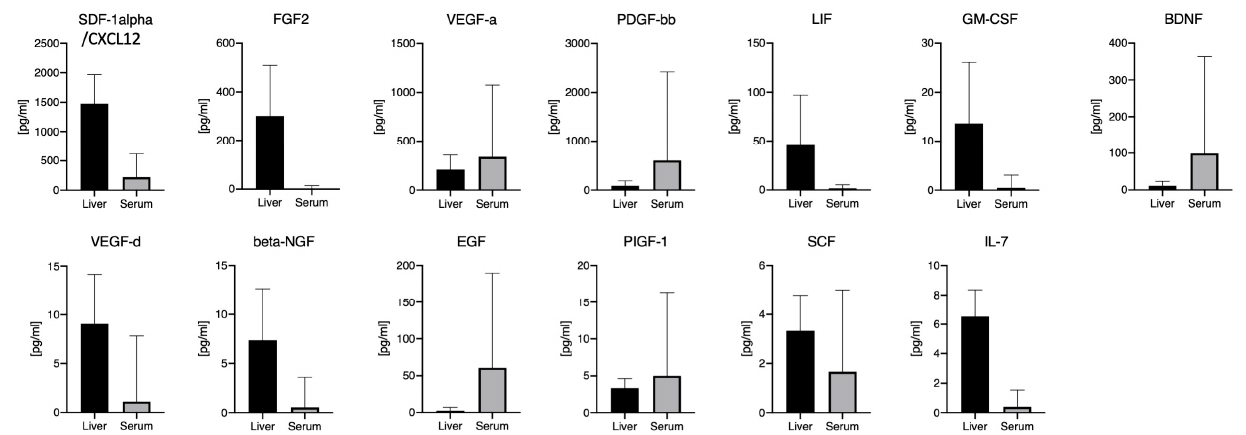
Figure 4. Comparing local (hepatic) and systemic (serum) levels in all 13 growth factors. Legend: Comparing multiplex measurements of 13 different growth factors from sera and livers of BA patients. The bar graph depicts the group means, the error bars depict the standard deviation.